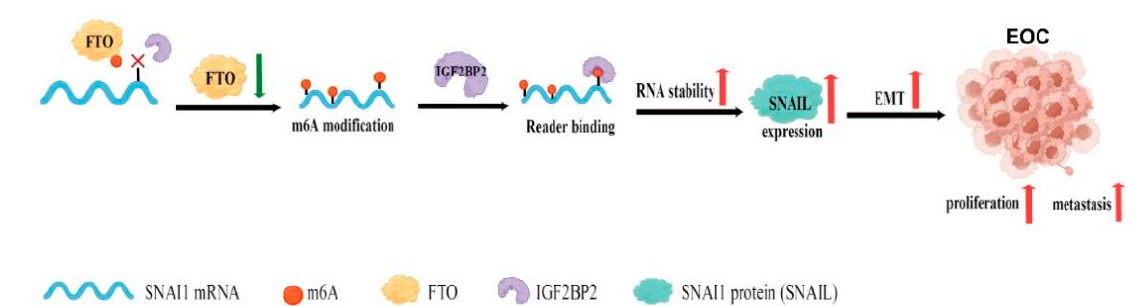
Figure 9. Schematic diagram of the present study (created with https://www.figdraw.com, accessed on 7 July 2022).